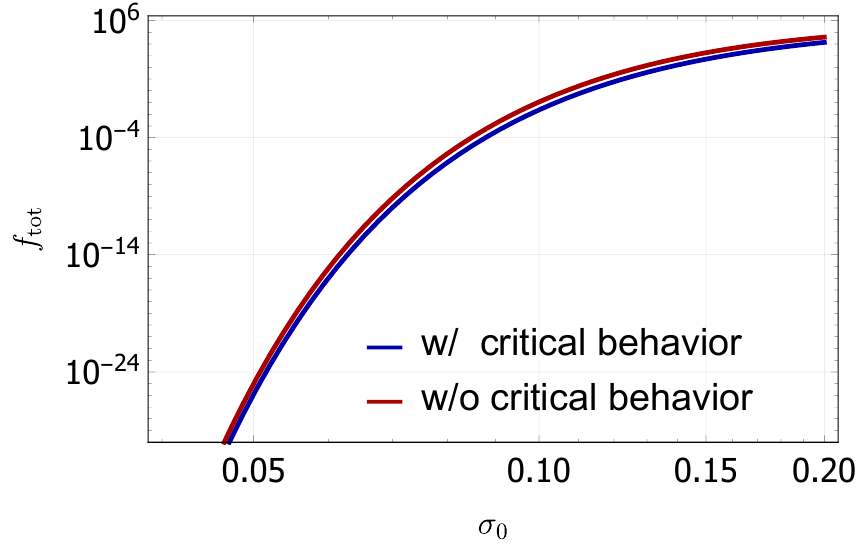
Figure 6. The total fraction f tot as a function of σ 0